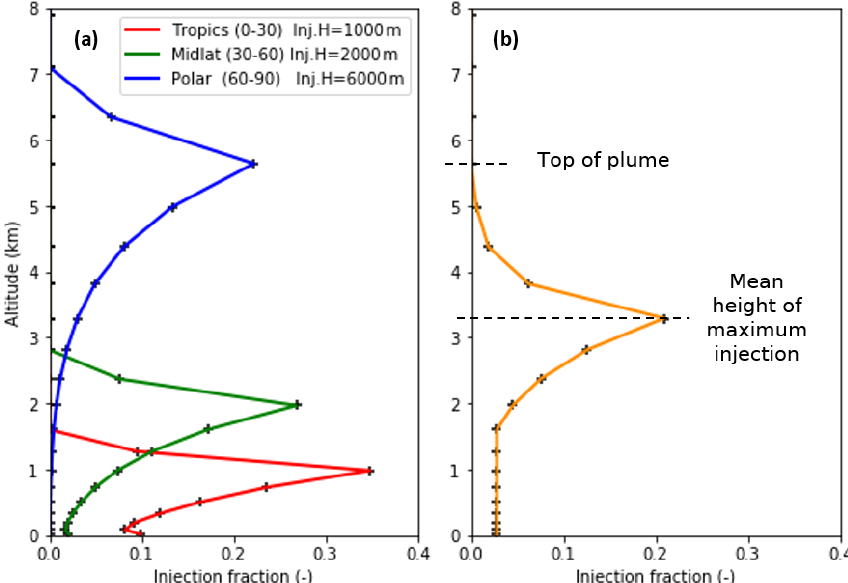
Figure 5. Injection profile schemes: (a) BASE injection profiles with latitude-dependent injection height; (b) INJH injection profile using GFAS plume rise